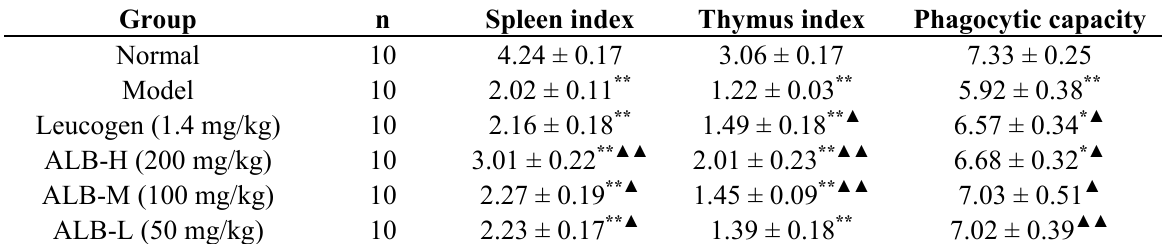
Table 2. The effects of lingonberry anthocyanins on organ/body weight ratio, phagocytic capacity of radiation in mice (mean ± S.D, n = 10) ( ** p < 0.01, * p < 0.05 vs. Normal; ▲▲ p < 0.01, ▲ p < 0.05 vs.